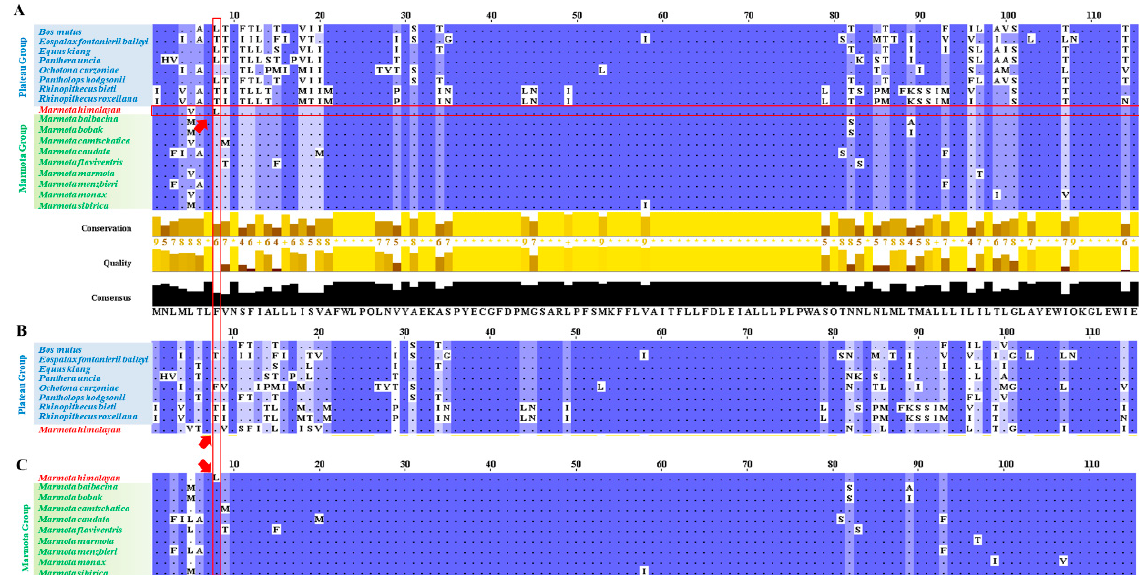
Figure 5. Nonconserved residues of ND3 amino acid sequence. The nonconserved ND3 amino acid sequence for all species ( A ), the plateau group ( B ), and the marmot group ( C ) were aligned in Jalview. The capital letters follow the standard notation for amino acids. Dark blue areas are highly conserved, while the light blue and white points represent divergent sequences. The nonconserved amino acid site in the Himalayan marmot is marked by a red rectangle, with the amino acid for the Himalayan marmot itself marked by red arrows.